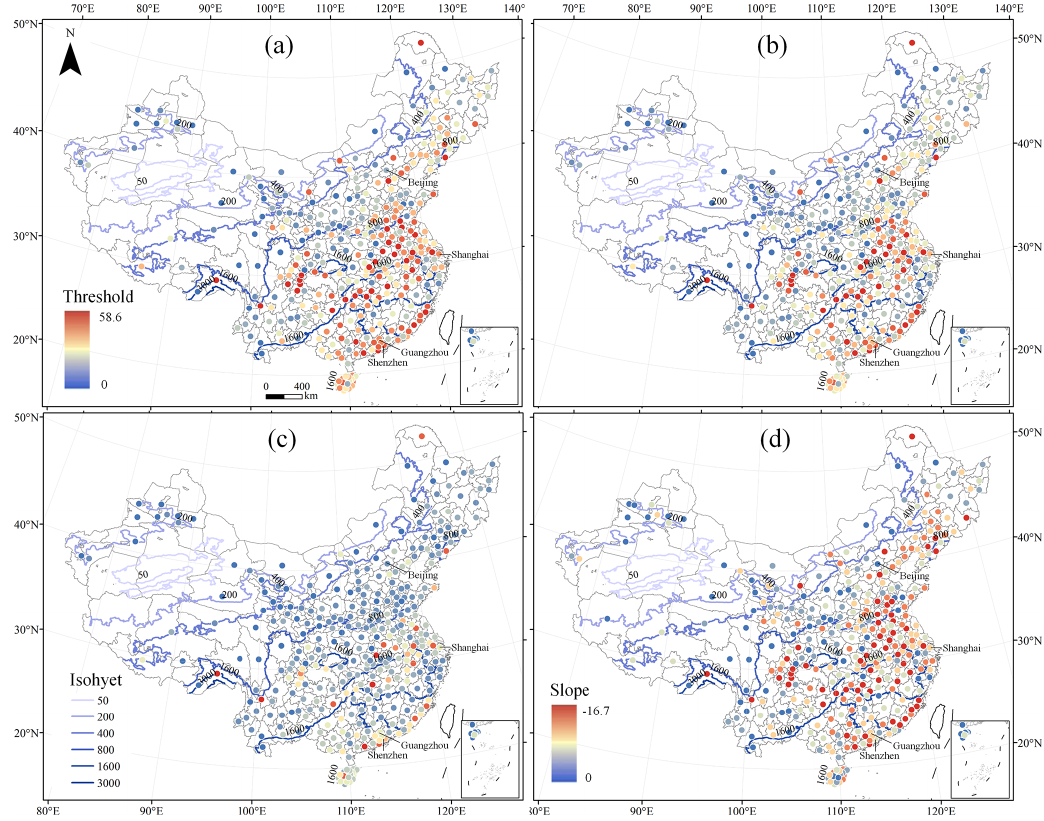
Figure 5. Spatial distribution of the rainfall threshold that triggers human activity anomalies for rainfall events lasting 3 (a) , 6 (b) , and 12h (c) and slope (d) of the decision boundary. The isohyets show the 2017 annual rainfall.